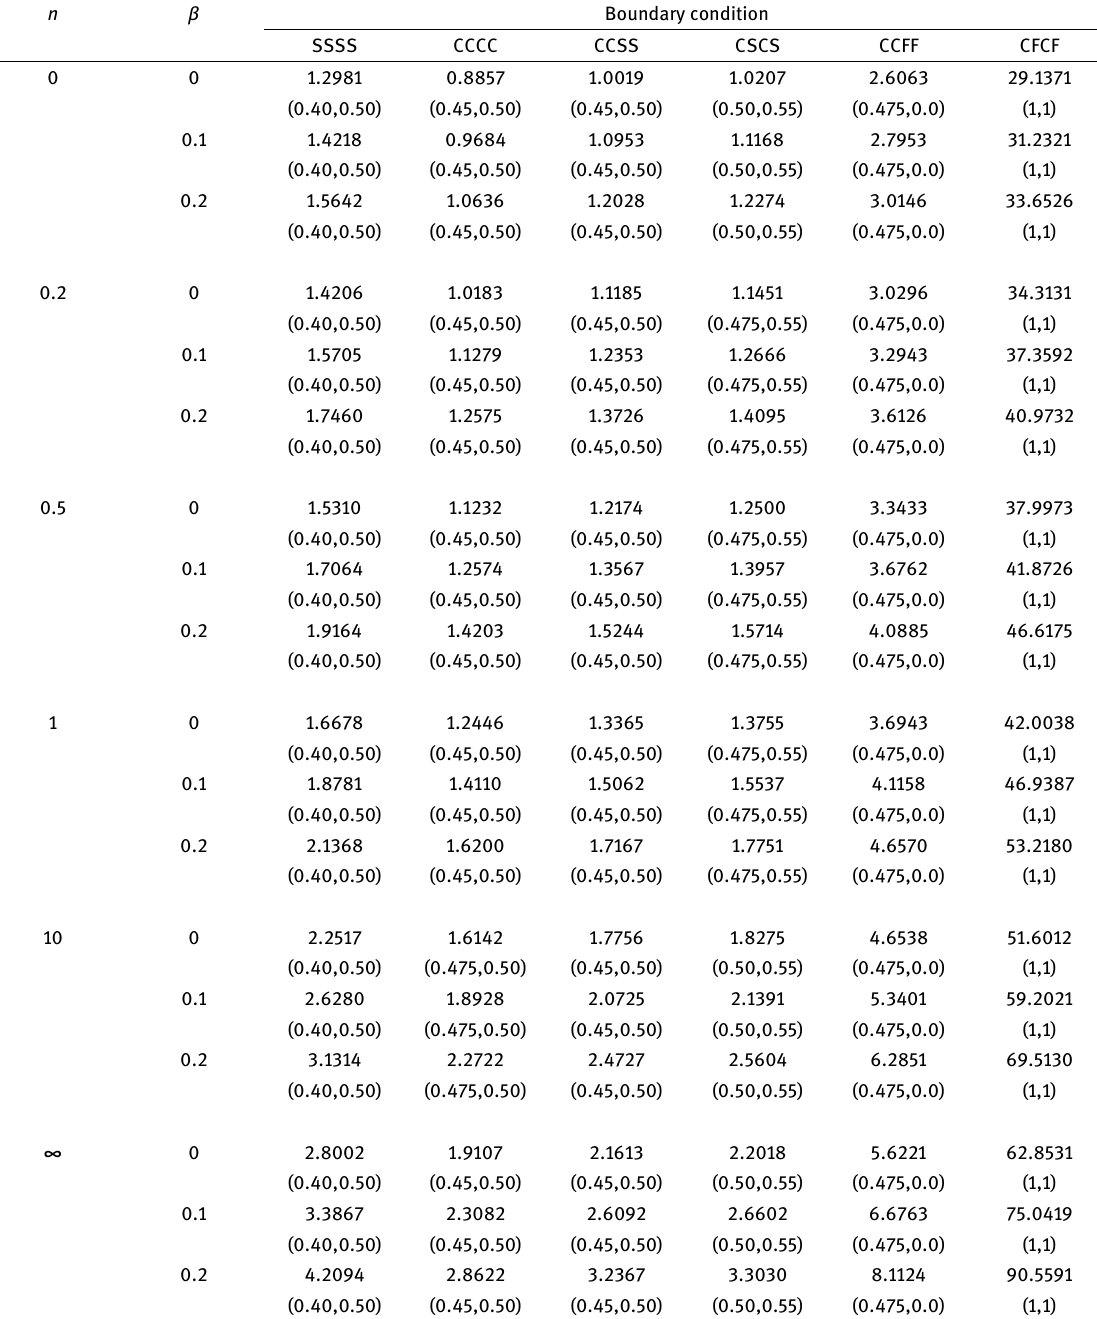
Table 3: Variation of non-dimensional deflection of FGM porous conoidal shell subjected to uniform loading.